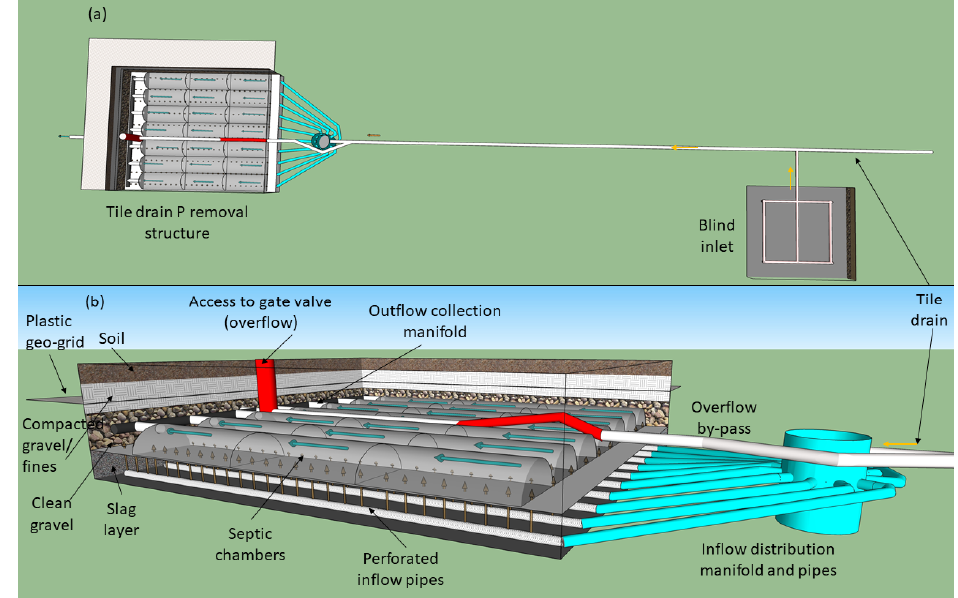
Figure 1. ( a ) Overhead view of the blind inlet/subsurface tile drain P removal structure, and ( b ) side view and details of the tile drain P removal structure. The blind inlet collects surface water at the site and is plumbed into the field tile drainage system, which is all treated by the subsurface P removal structure. The yellow and blue arrows indicate the flow path of the untreated and treated water, respectively. Water flows from the bottom-up and discharges at the same elevation as the inlet.